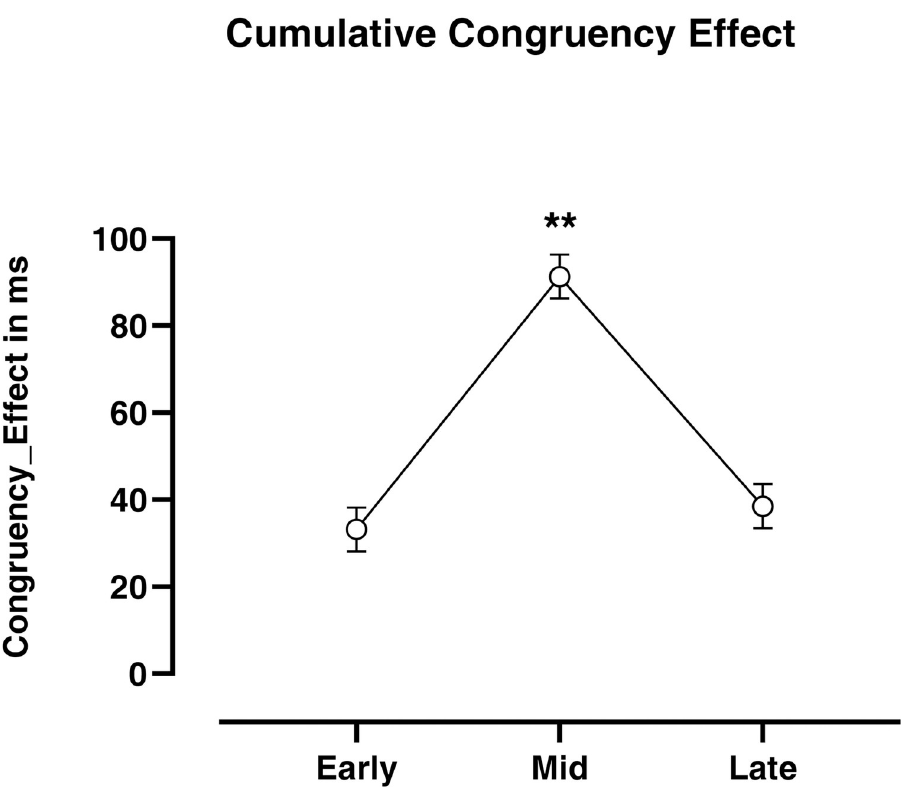
Fig 5. Conflict’s temporal unfolding phases. The line-plot graphs represent the Early, Mid and Late phases, according to which the temporal unfolding of the decision towards the target choice in the MT-race-IAT was dissected. Values are expressed as mean ± SEM; �� p < .001 (corrected for Tukey’s correction for multiple comparisons).